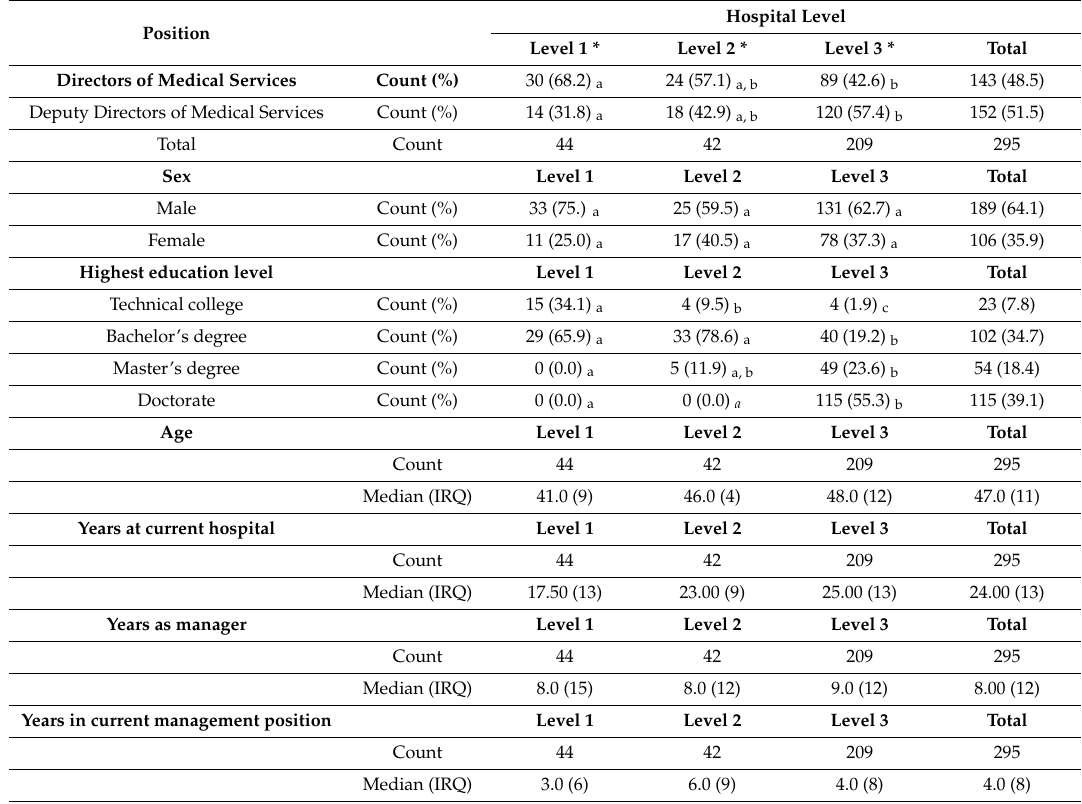
Table 1. Characteristics of participants by